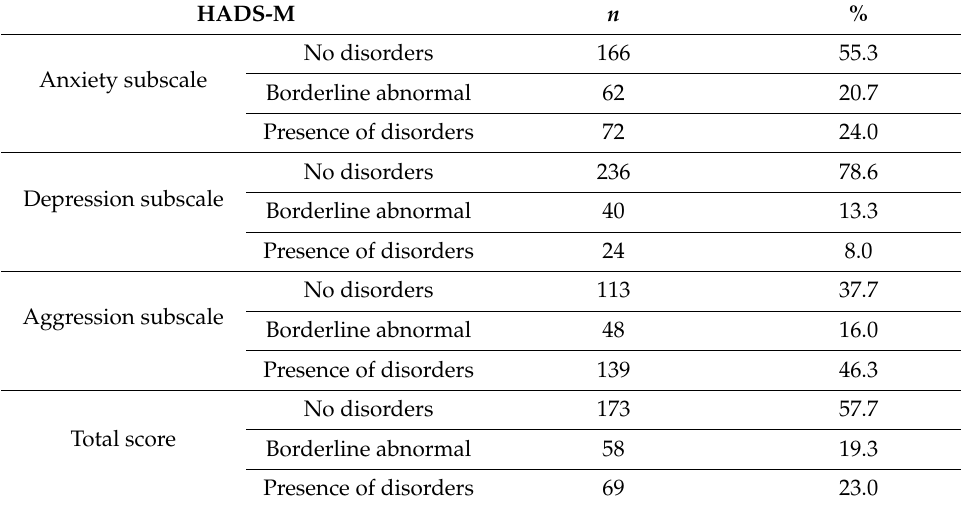
Table 1. Subjects’ HADS-M